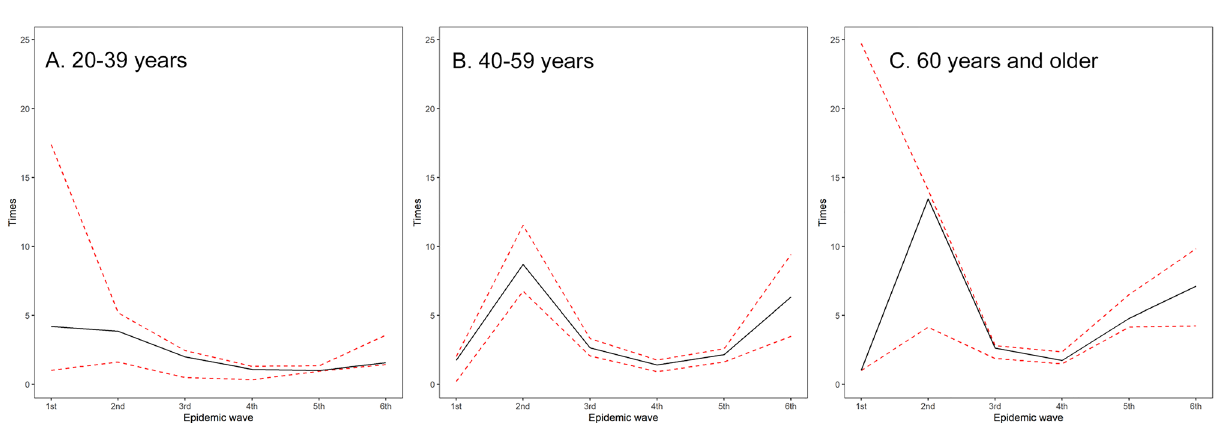
Figure 2. Ascertainment bias estimates by age group and epidemic wave in Osaka, Japan, 2020–2022. The horizontal axis shows the epidemic wave in Japan from 2020 to 2022, and the vertical axis represents the estimated ascertainment bias. Ascertainment bias is expressed as the ratio of the estimated number of infections to the observed number of confirmed cases. The left panel ( A ) shows estimates for young adults aged 20–39 years, the middle panel ( B ) for those aged 40–59 years, and the right panel ( C ) shows estimates for those aged 60 years and older. The solid lines show least square estimates, and the red dashed lines show 95% confidence intervals computed using the bootstrap